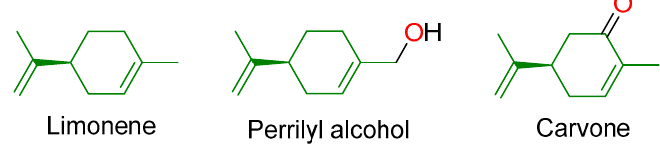
Figure 2. Some menthane-derived monoterpenoids.